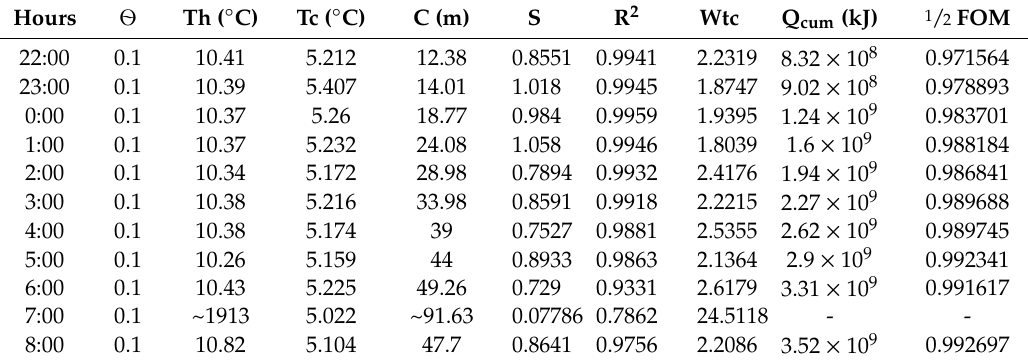
Table A7. 12th–13th October 2019 Curve Fitting and Performance Parameter analysis.